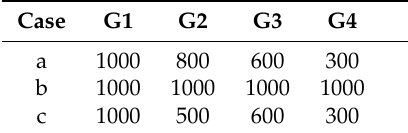
Figure 5. Curve of four panels in series changing its partial irradiance ( G ). Table 1. Partial shading (W/m 2